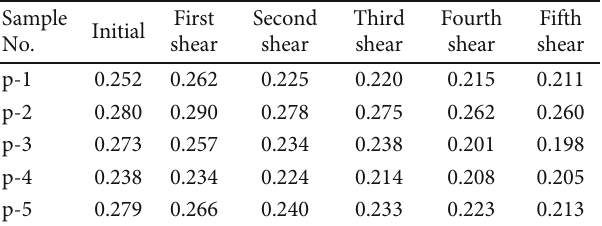
Table 1: Root-mean-square values of discontinuities.